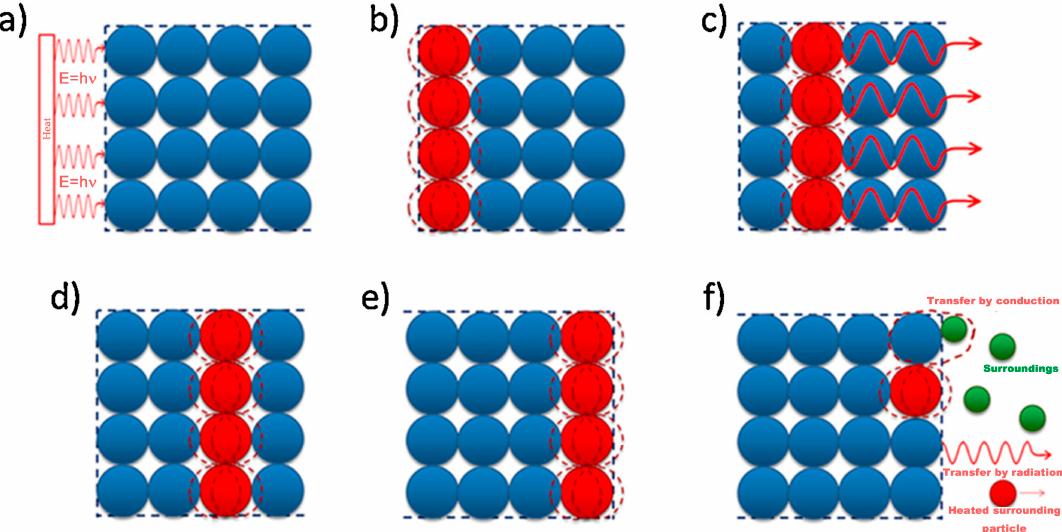
Figure 1. The schematic of thermal conductance in a crystalline material [29]. Copyright (2016), with permission from Elsevier.